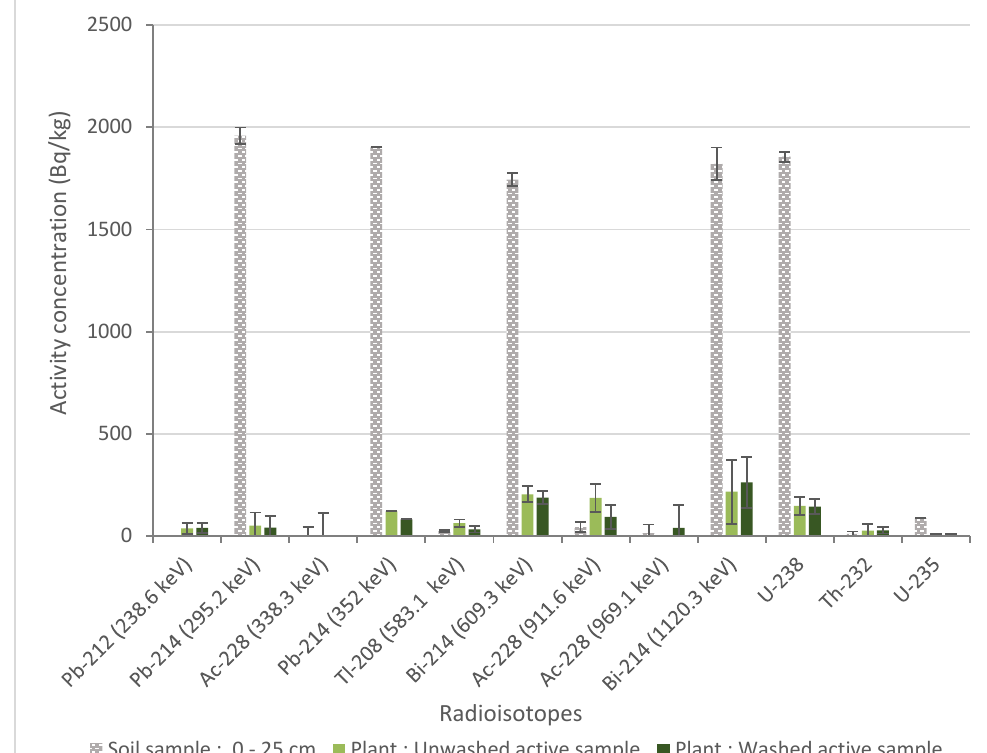
Figure 4. Radioactive sample — activity concentrations for radioactive soil and plant samples before and after washing.